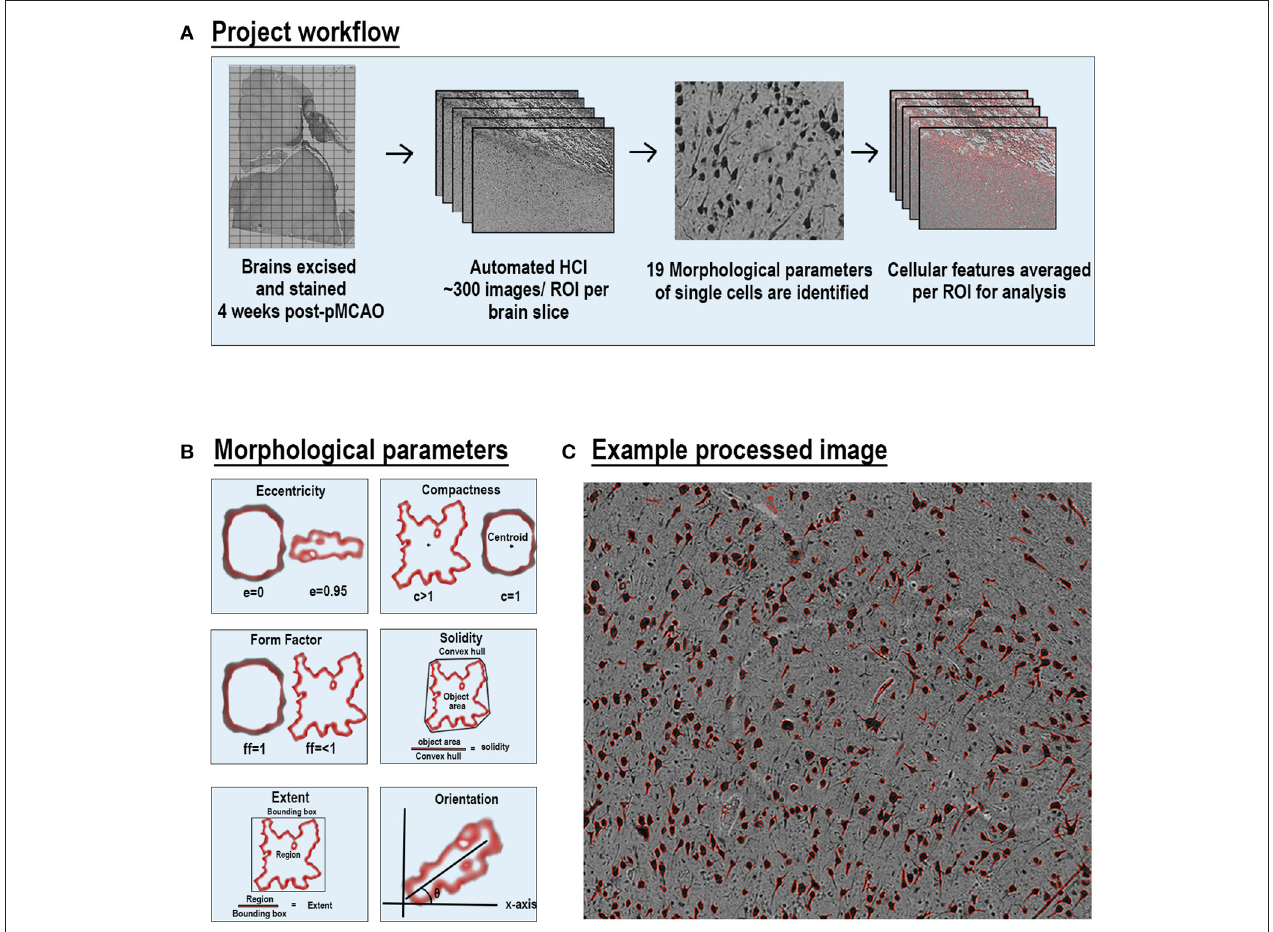
FIGURE 1 | Automated high-content image processing pipeline and morphological parameters. Diagram of multiparametric HCI processing pipeline of cellular features from S and NS animals (A) . Explanation of 6 of the 19 morphological parameters measured for each cell per ROI (B) . Representative NeuN stained ROI after processing with outlines (red) of each positve cell area (C) .